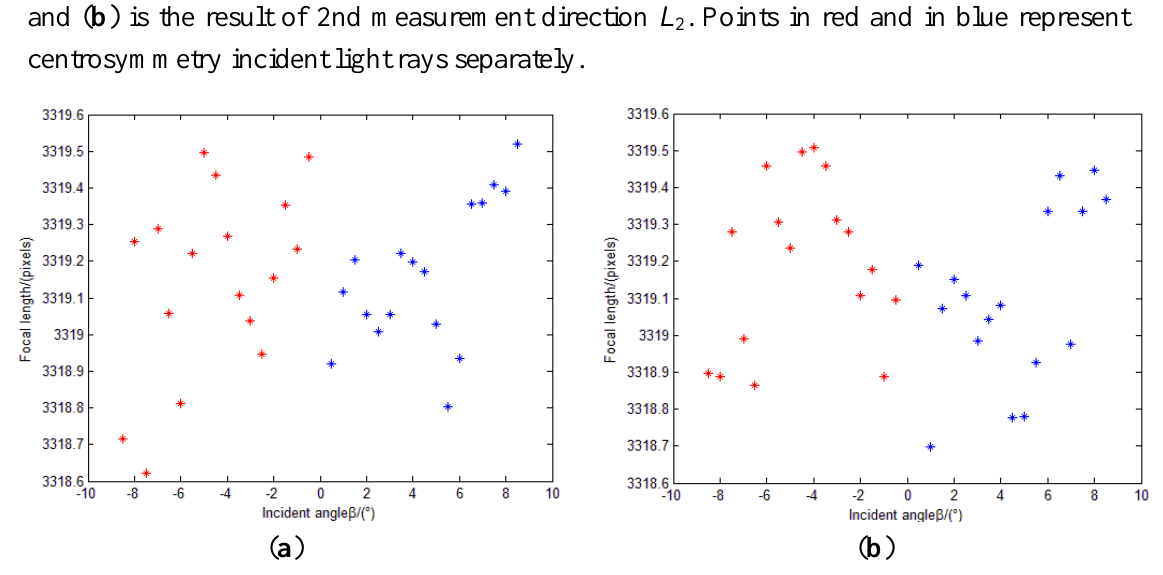
. Points in red and in blue represent 2